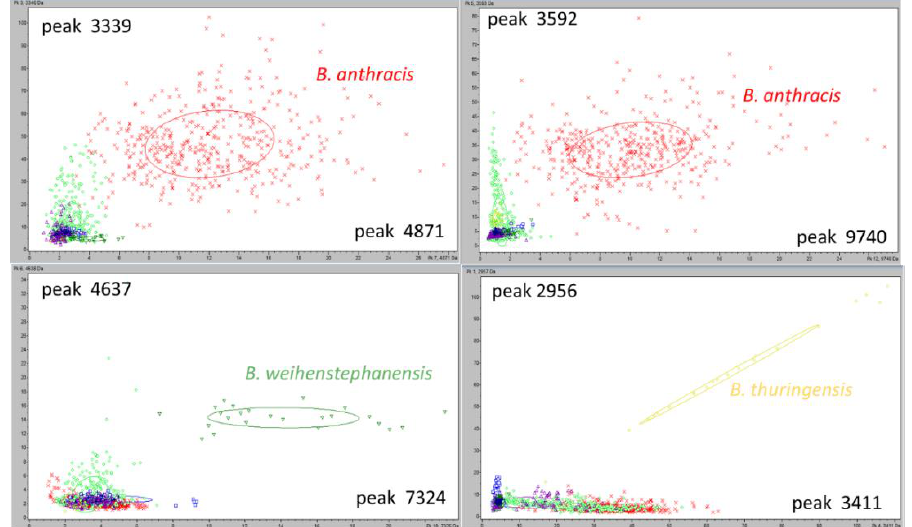
Figure 4. Two-dimensional scatter plot of characteristic ion peaks for B. anthracis , B . weihentepha- nensis and B. thuringensis . The characteristic peaks served as the x- and y-axes, respectively. The intensities of the characteristic ion peaks were expressed in arbitrary intensity units. The ellipses represent the 95% confidence intervals of peak intensities for each species.